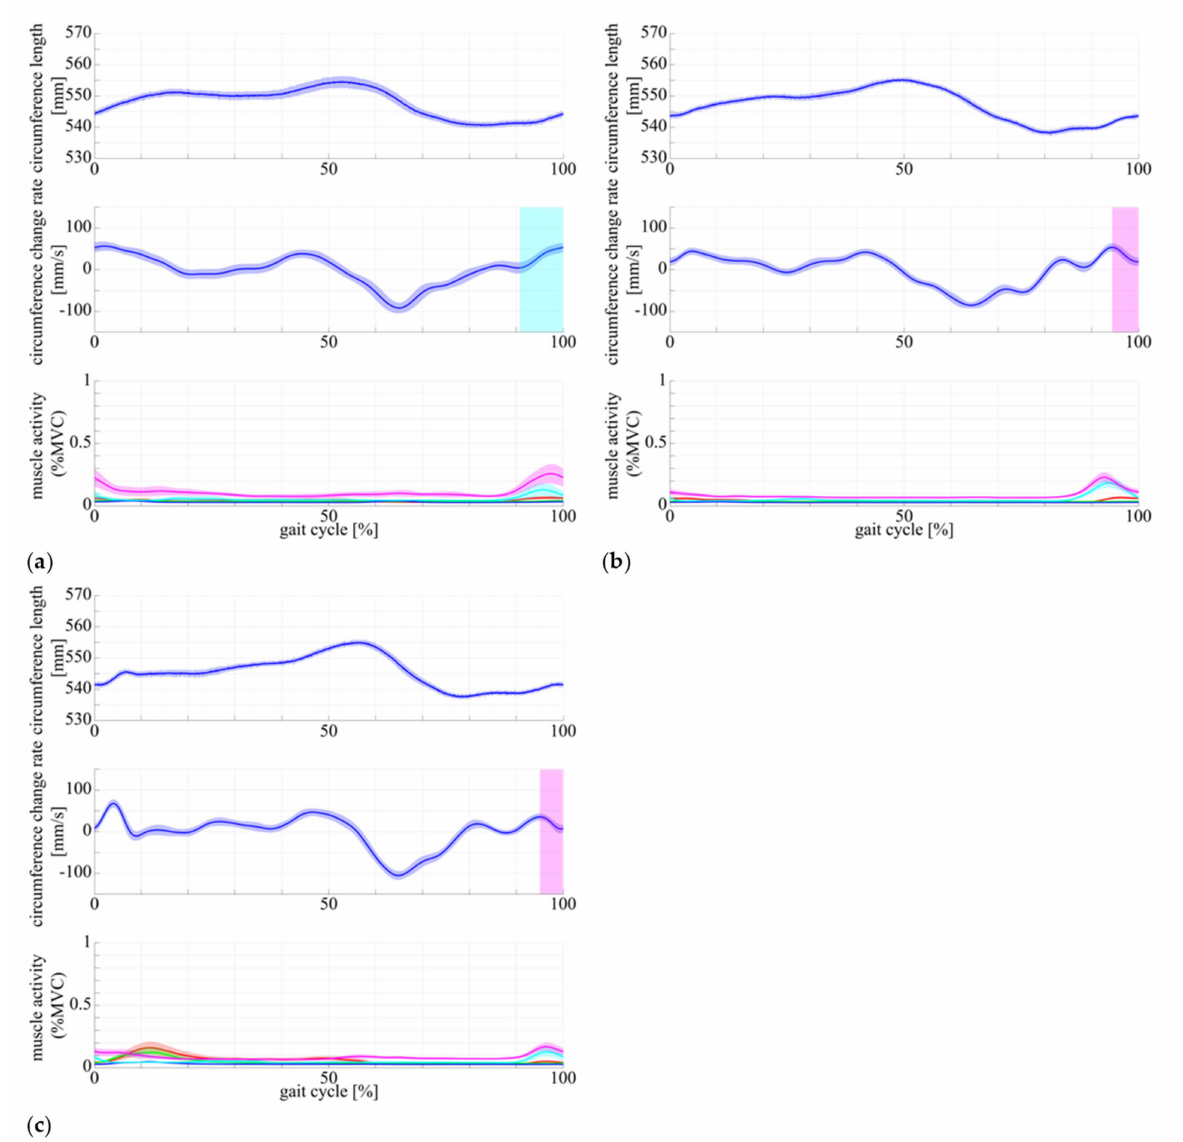
Figure 6. Stretch length, velocity, and muscle activity of walking with ( a ) conscious muscle co-contraction, ( b ) neutral, and ( c ) conscious muscle relaxation. The horizontal axis represents the gait cycle (%), and the vertical axis represents the stretch length (mm) in top, stretch velocity (mm/s) in middle, and muscle activity normalized by MVC in bottom. Each color of line represents same item as the one in Figure